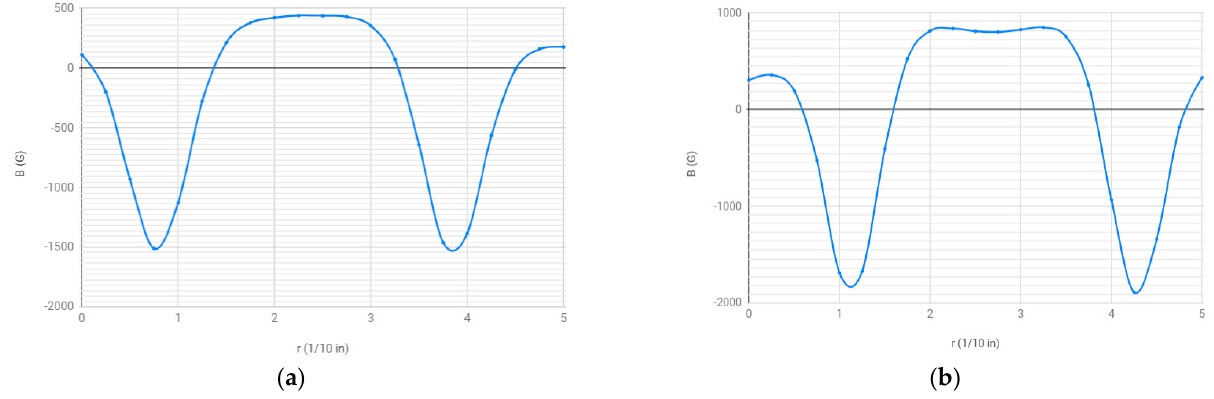
Figure 8. Magnet transverse B-field profiles (3/8 ″ × 1/4 ″ × 1/16 ″ ): ( a ) single; ( b ) assembly. Colloidal graphite was used to stabilize the exposed surfaces and minimize stray pump laser reflections. An ultra-high vacuum (UHV) chamber compatible mount was manufactured retaining the 1/16 (cid:48)(cid:48) gap, illustrated in Figure 9. A total of 80 and 180 mil separation between the top and bottom brackets versions allowed vacuum experiment and bench probing, respectively. The transverse Gauss meter wand is ~160 mil wide. Profile results are shown in Figure 8, revealing a 0.1” to 0.15” collimated B-field diameter in (b).